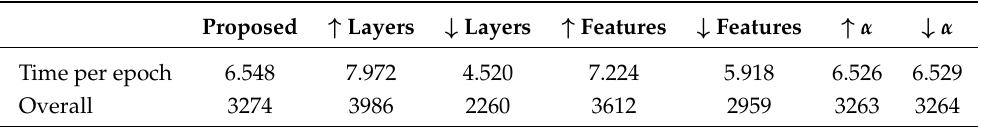
Table 3. Training time in seconds for a single epoch and for the overall training (500 epochs), for different hyperparameter